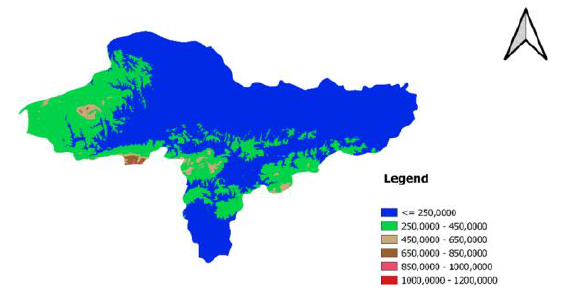
Figure 2 . Varaždinska county digital terrain